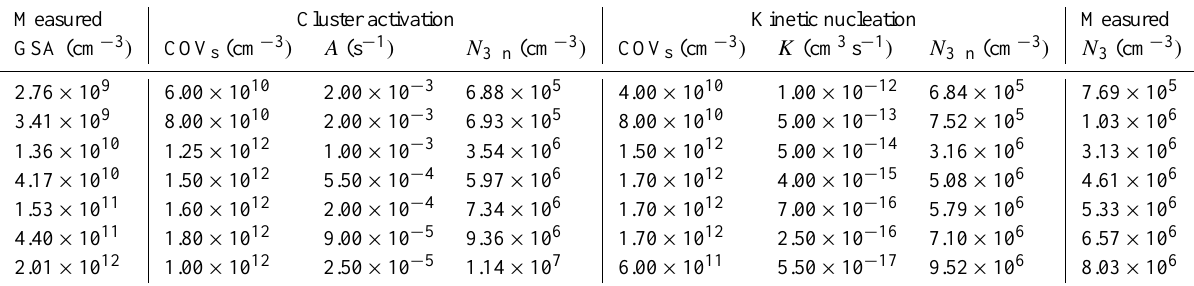
Table 3. Shown here are the initial condensable organic vapour concentrations (COV s ) and activation coefficient ( A ) as well as the initial COV s and kinetic coefficient ( K ) as a function of the initial gaseous sulfuric acid concentration (GSA). Also shown is the predicted and measured number concentration of particles larger than 3nm ( N 3 ) at the end of the ageing chamber. For heterogeneous nucleation, GSA, COV s , and N 3fin are as for kinetic nucleation, but K 1 = 3.8 × 10 − 17 and K 2 = 5.6 × 10 − 17 cm 3 s − 1 for each case. Measured Cluster activation Kinetic